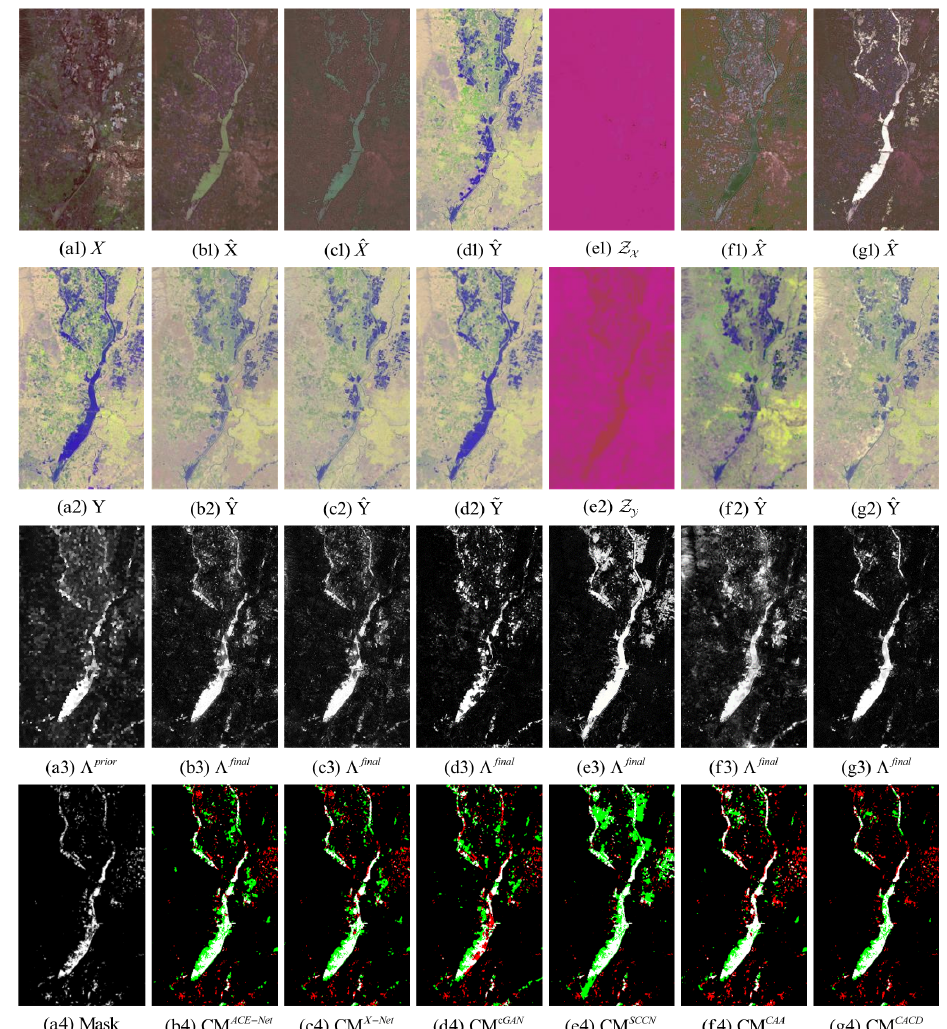
Figure 9. California dataset. ( a1 ) Input image X . ( a2 ) Input image Y . ( a3 ) Prior difference matrix generated by IRG-McS. ( a4 ) Real mask. ( b – g ) represent the results of ACE-Net, X-Net, cGAN, SCCN, CAA and CACD (US) methods, respectively. ( b1 , c1 , f1 , g1 ) transformed image ˆ X . ( d1 ) transformed Y domain image ˆ Y . ( e1 ) code image Z X . ( b2 , c2 , f2 , g2 ) transformed image ˆ Y . ( d2 ) approximate Y domain image ˜ Y . ( e2 ) code image Z Y . ( b3 , c3 , d3 , e3 , f3 , g3 ) final difference map. ( b4 , c4 , d4 , e4 , f4 , g4 ) confusion map, where white: true positives (TP), black: true negatives (TN), green: false positives (FP), red: false negatives